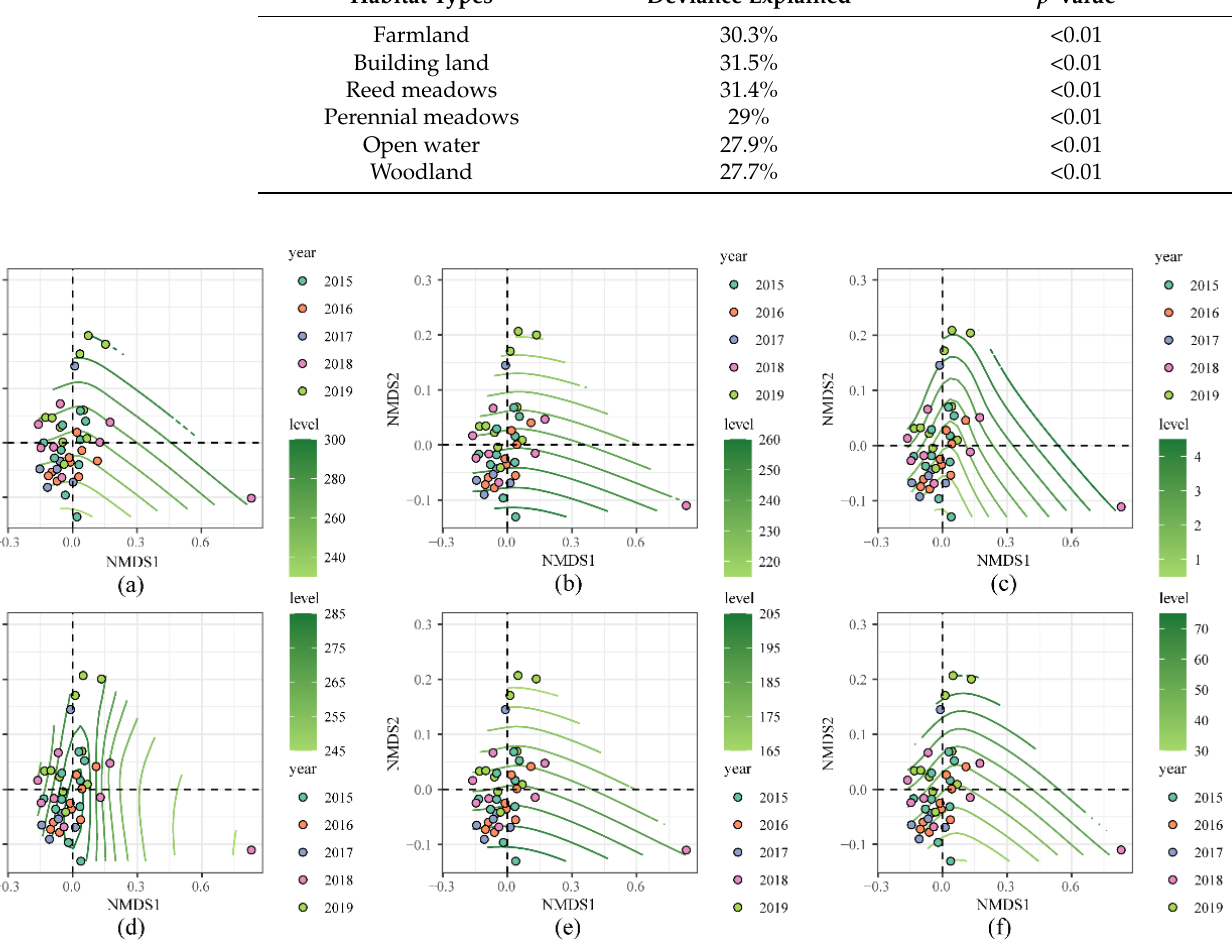
Figure 6. Non-metric multidimensional scaling (NMDS) plots of bird community composition, with smooth response curves of habitat types using generalized additive models. Points indicating bird community composition on NMDS plots are colored by years. Green curved splines show the nonlinear fit of habitat types from high levels to low levels (from dark green to light green). ( a ) Building land; ( b ) open water; ( c ) woodland; ( d ) farmland; ( e ) perennial meadows; ( f ) reed meadows.